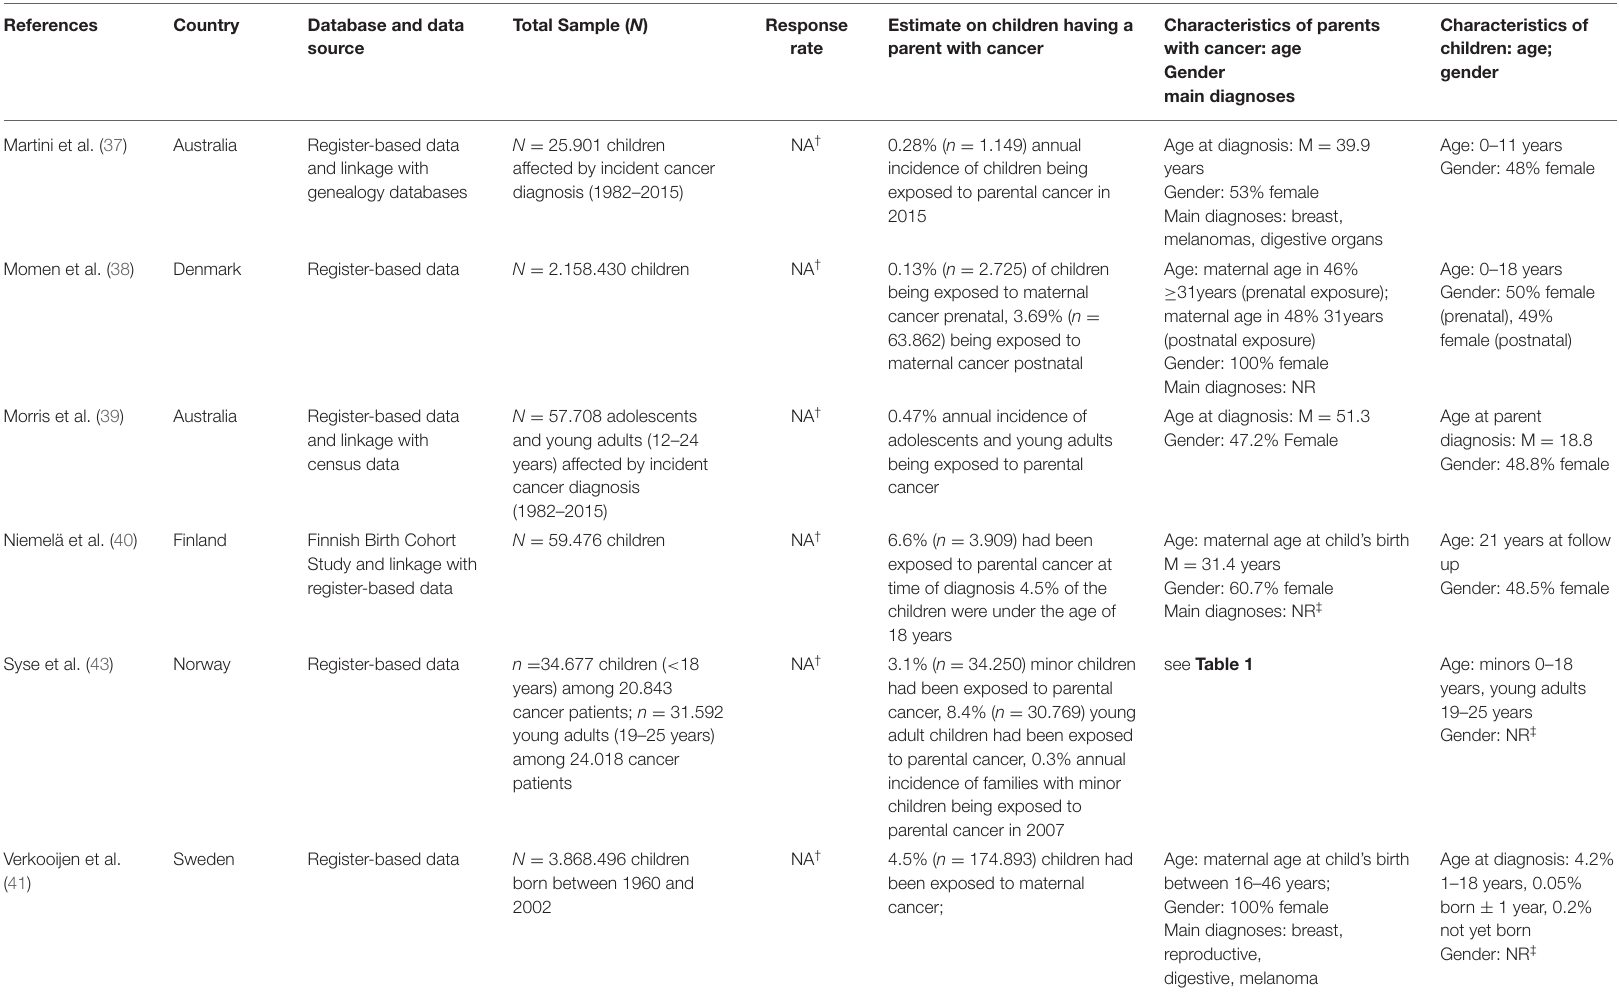
reproductive, digestive, melanoma